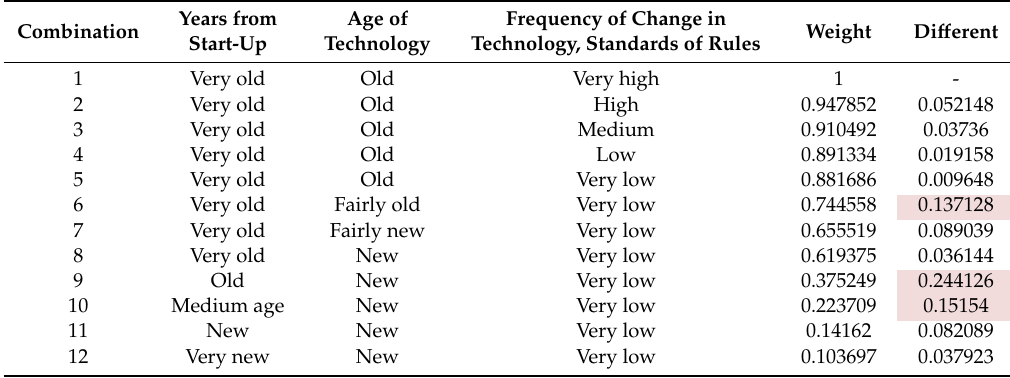
Table 18. Top–down technique for the criterion Age of